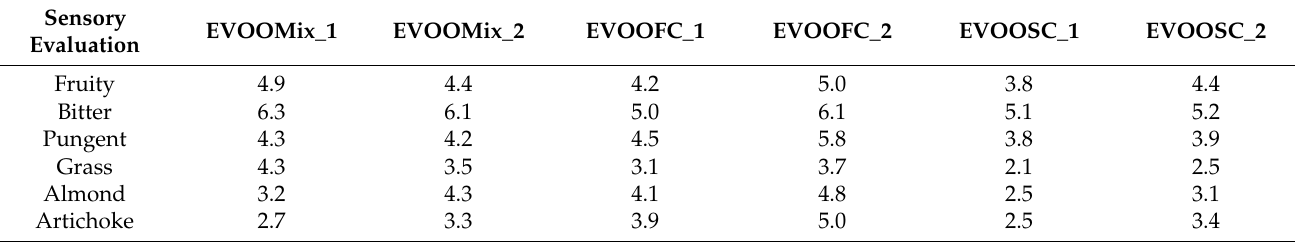
Table 5. Sensory profile of the analysed